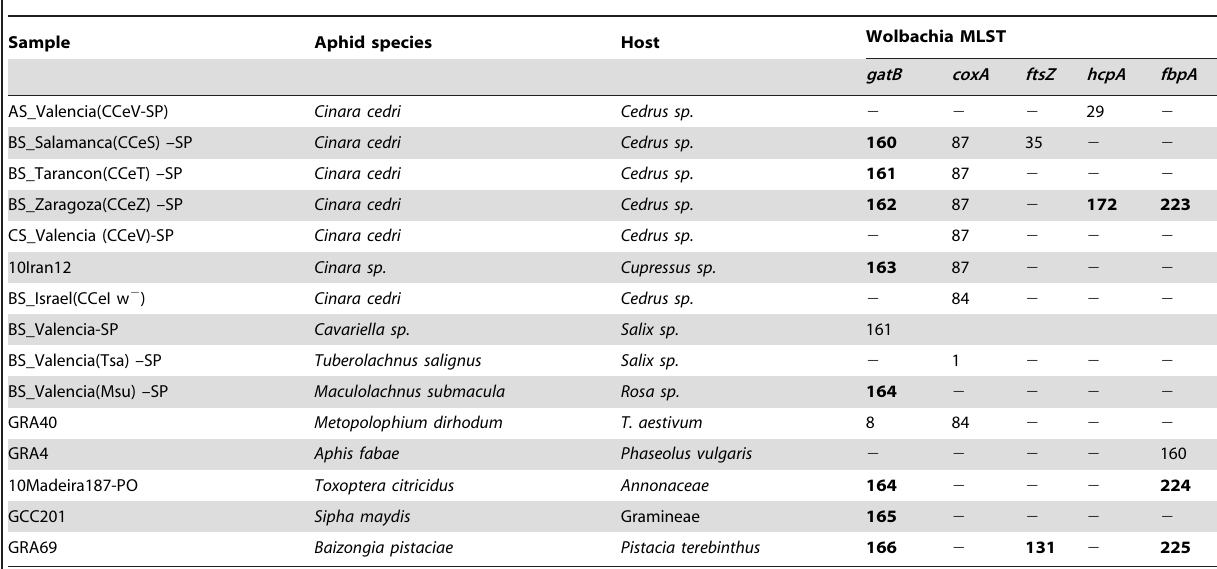
Table 2. Wolbachia MLST allele profiles for positive aphid populations.